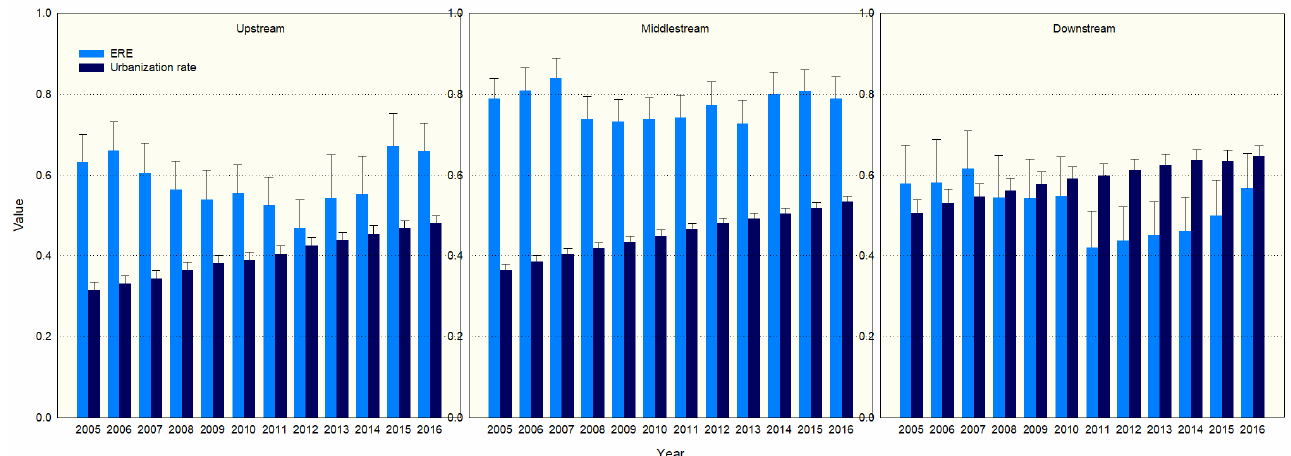
Figure 4. Regional ERE and urbanization rate grouped bar charts with error bars.